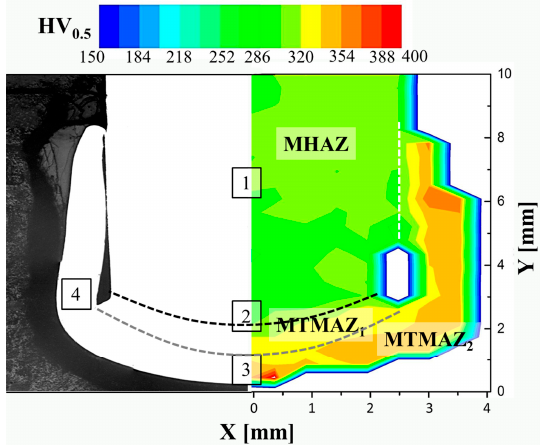
Figure 16. Vickers microhardness map of the Ti-6Al-4V deformed rivet showing the microstructural zones in the rivet from a specimen produced under the HEI joining condition.